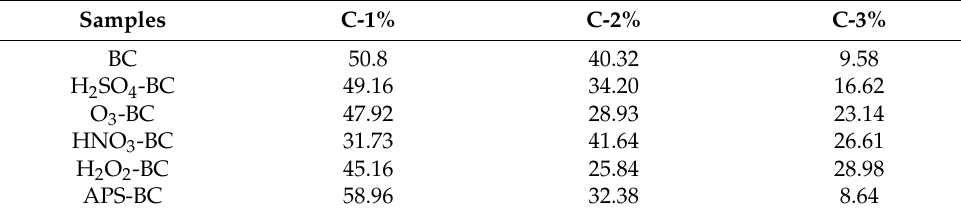
Figure 3. Deconvolution of C1s spectra for all the biochar samples. C-1: sp 2 hybridized carbon; C-2: C-O bonds; C-3: C=O bonds. Table 5. Relative contents of C1s peaks in biochar samples obtained by XPS spectra.